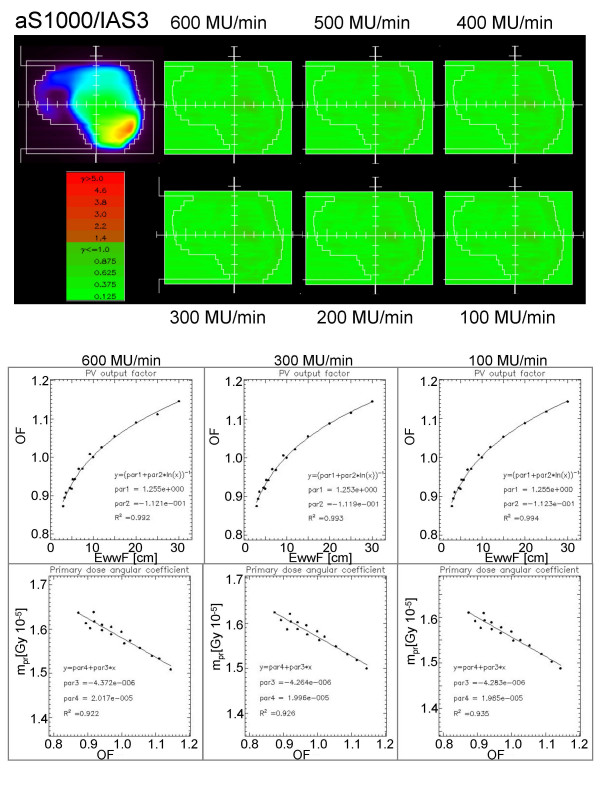
Summary of Dose Rate independence study for the IAS3 read-out electronics (associated to the PV-aS1000 detector). Example of Gamma Evaluation matrices (DTA = 3 mm, ΔD = 3%) for a field measured with beam delivery operated at dose rates from 100 to 600 MU/min while dose calculation was performed at 300 MU/min. Plots of the calibration data acquired at different dose rates and corresponding fits.